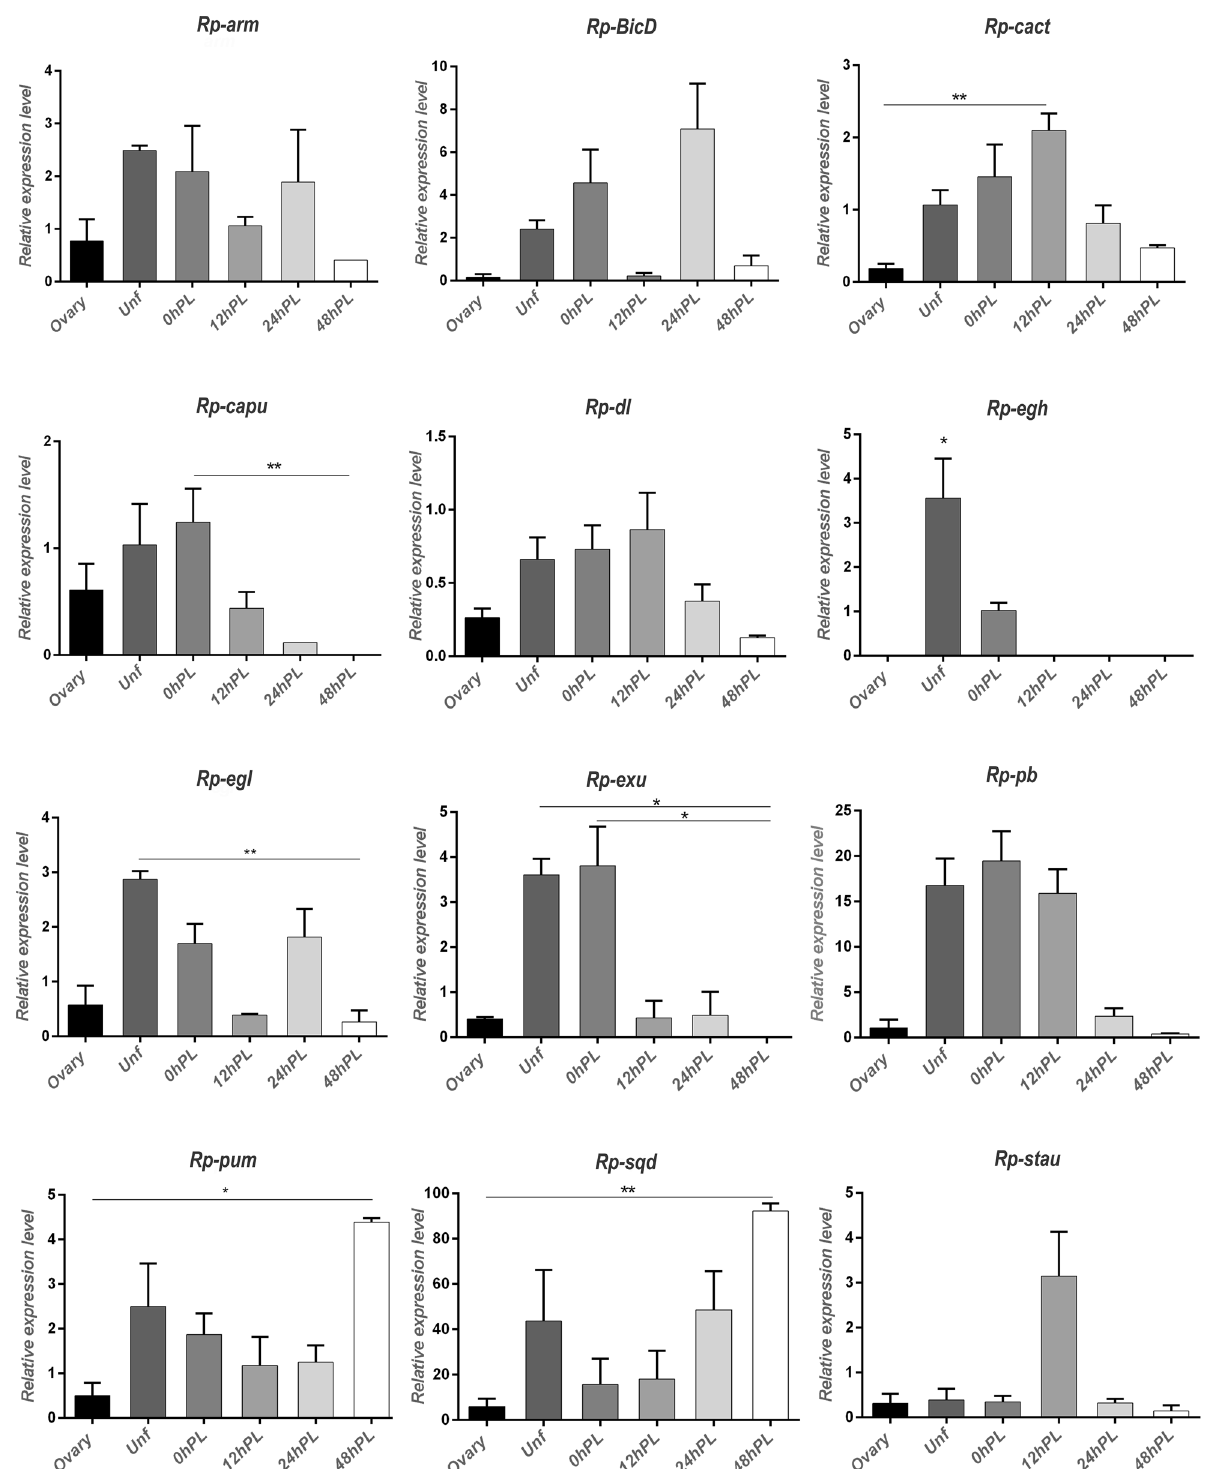
Figure 4. Real-time quantitative PCR of expression of candidate genes in the different stages. X axis: developmental times analyzed. Y axis: expression relative to the reference gene. Values are expressed as mean ± SEM of 3 independent experiments. Rp-arm : Armadillo ; Rp-BicD: Bicaudal D ; Rp-cact: Cactus ; Rp-capu: Cappuccino ; Rp-dl: Dorsal ; Rp-egh: Egghead ; Rp-egl: Egalitarian ; Rp-exu: Exuperantia ; Rp-pb: Proboscipedia ; Rp-pum: Pumilio ; Rp-sqd: Squid ; Rp-stau: Staufen . Graphs were performed using GraphPad Prism 7. * < 0.1; ** <